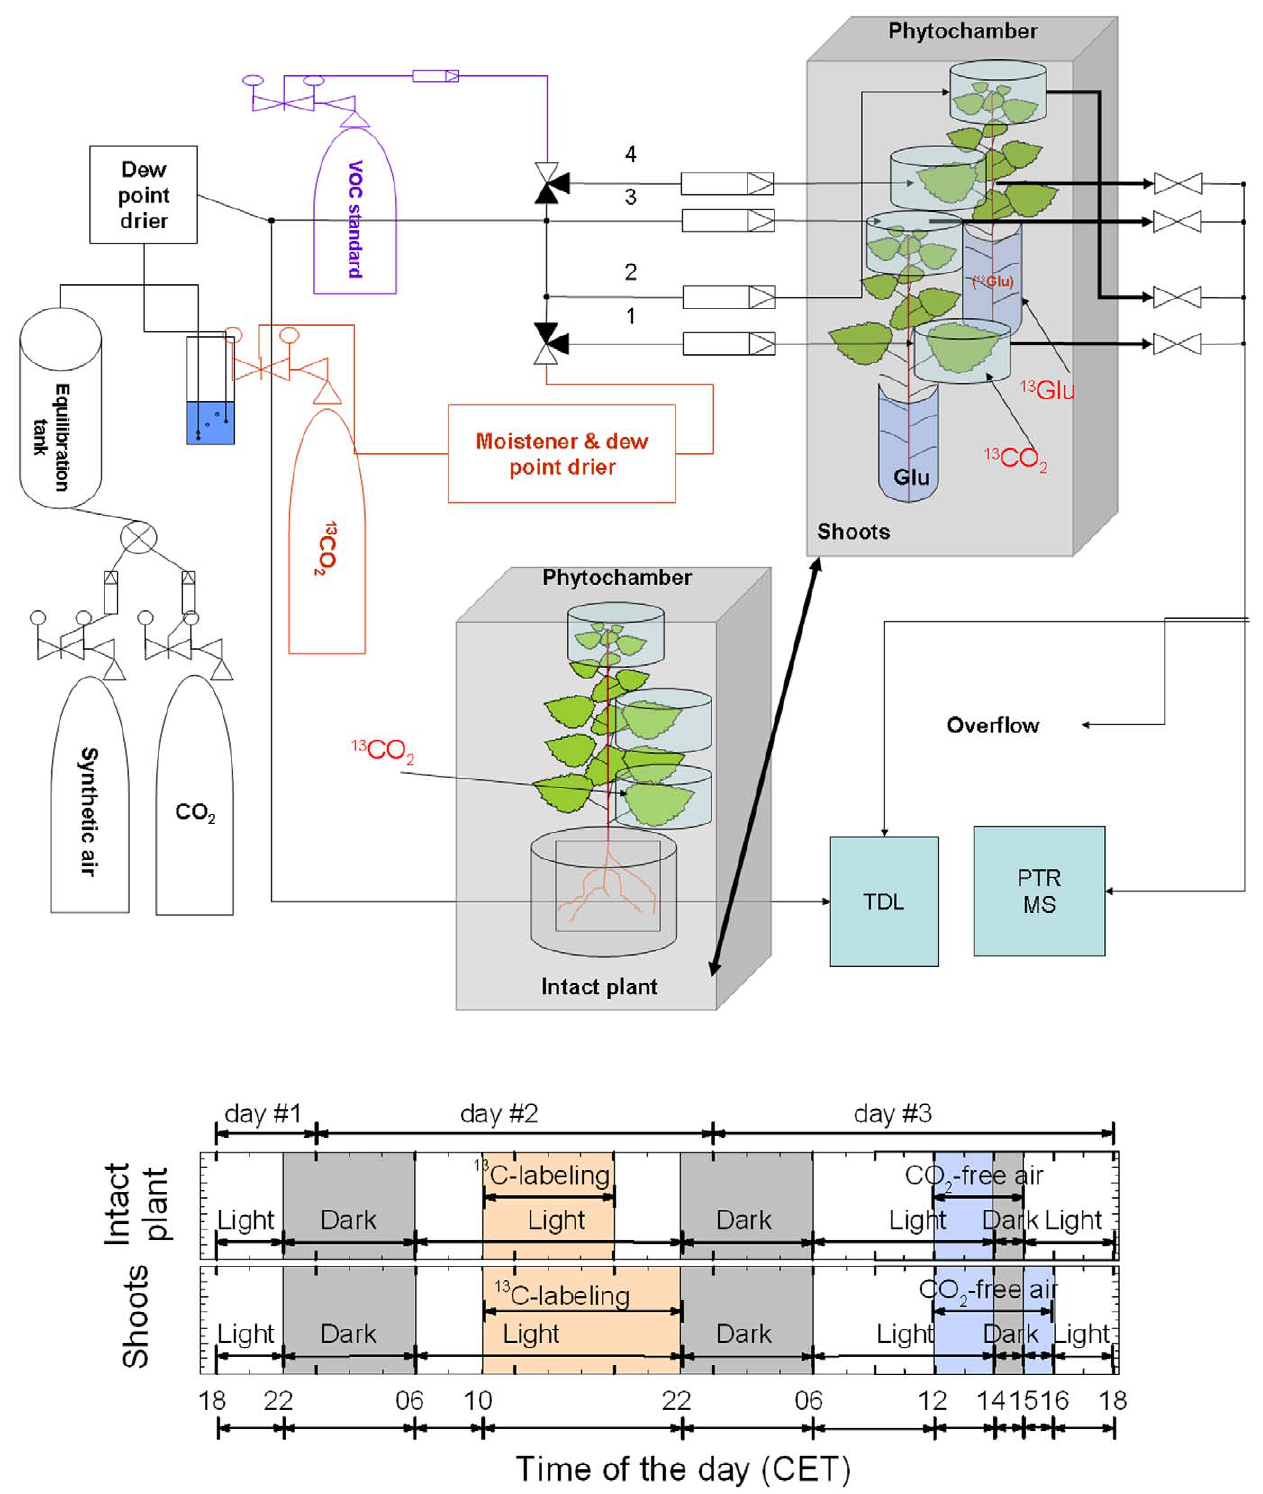
Figure 1. Scheme of the experimental design. Ten liter per minute of synthetic VOC-free air (BASI Scho ¨ berl, Germany) were mixed with CO 2 (38,000 ppmv) to a final concentration (in the cuvette) of 385 ppmv, passing a 20 L equilibration tank before being completely humidified by bubbling the airstream through pure, distilled water. A dew point unit assured a stable humidity level before the airflow entered each of the four cuvettes through flow controllers, set at 2 L min 2 1 . One cuvette ( # 1) could be connected via a 3-port valve to a separate 13 CO 2 -tank for 13 C-labeling. The gas was purchased already mixed at 385 ppmv 13 CO 2 and humidified separately using a portable dew point generator (Li-610, Licor, Lincoln, NE, USA). Another cuvette ( # 4) was connected to a VOC standard mixture for the calibration of the PTR-MS. Inlet and outlet of the cuvettes were directed sequentially via electronic, computer controlled 3-port valves to the three gas analyzers (LI-7000, Licor; or GFS-3000, Heinz Walz, Germany; TDLAS; PTR-MS), while the excess flow was directed to a vent which was periodically checked for flow rate in order to ensure that the whole system PLoS ONE |